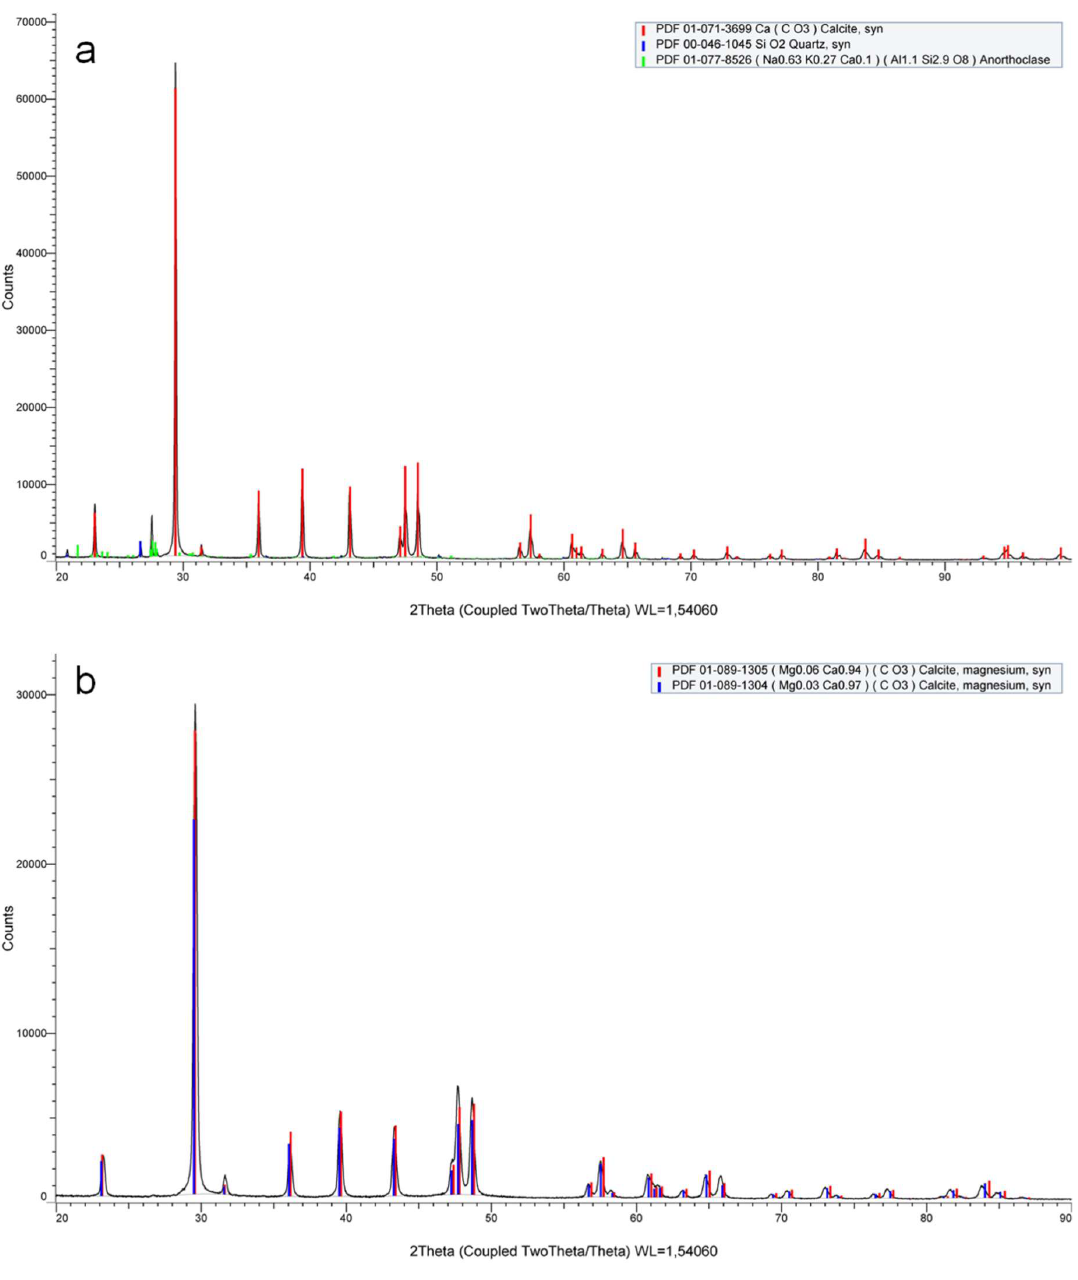
Figure 2. Diffractograms of representative samples of carbonate neoformations: ( a ) bark on the facades of the second level of the embankment; and ( b ) stalactite-like formations of the second level of the embankment.